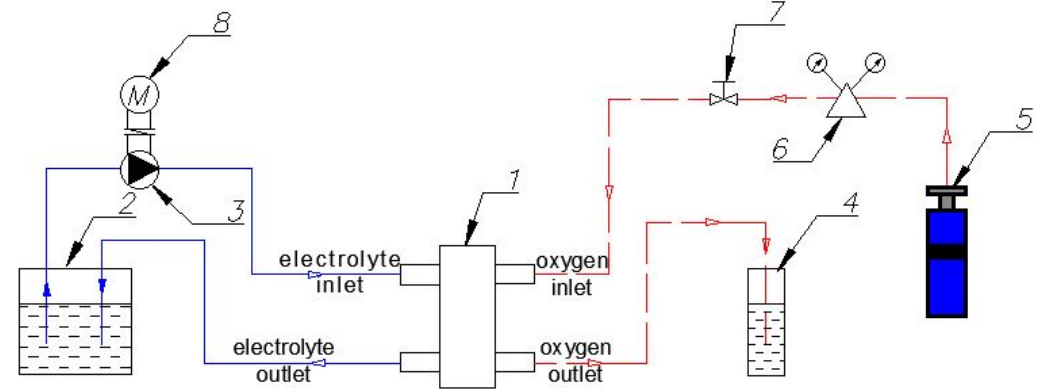
Figure 3. Scheme of the experimental setup: 1—BFC; 2—Reservoir with electrolyte solution; 3—Circulation pump; 4—Reservoir with water (control of O 2 flow through the system); 5—Oxygen cylinder; 6—Reducer with pressure gauges; 7—Fine adjustment valve; 8—Electric engine.